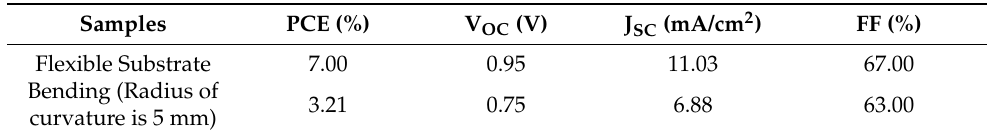
Figure 5. Reverse scanning J–V curves for pristine flexible PSC prepared with SnO 2 colloid solution of the concentration of 5 wt.% and the PSC after bending. (The illustration is the photograph of F-PSC). Table 3. Parameters calculated from reverse scanning J–V curves for flexible PSC fabricated with SnO 2 colloid solution of the concentration of 5